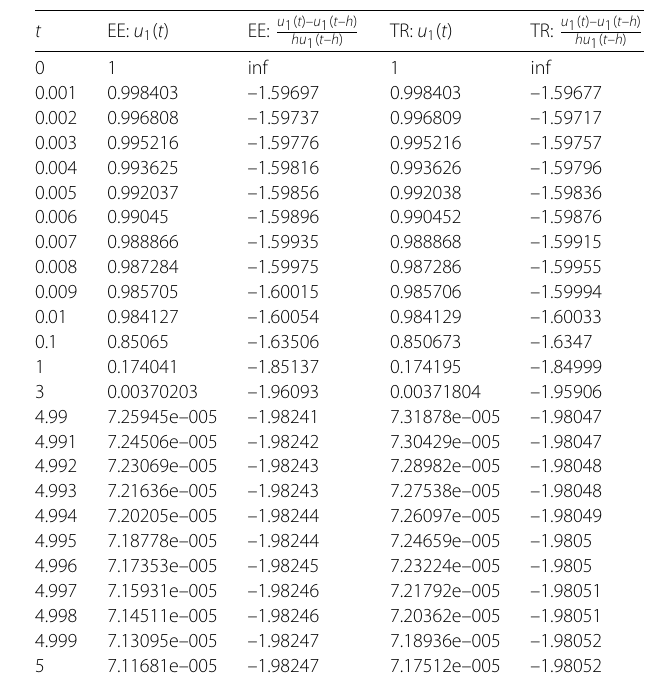
Table 2 Poincaré-type differential equation: Numerical calculation of the one-dimensional subspace defined by the subdominant